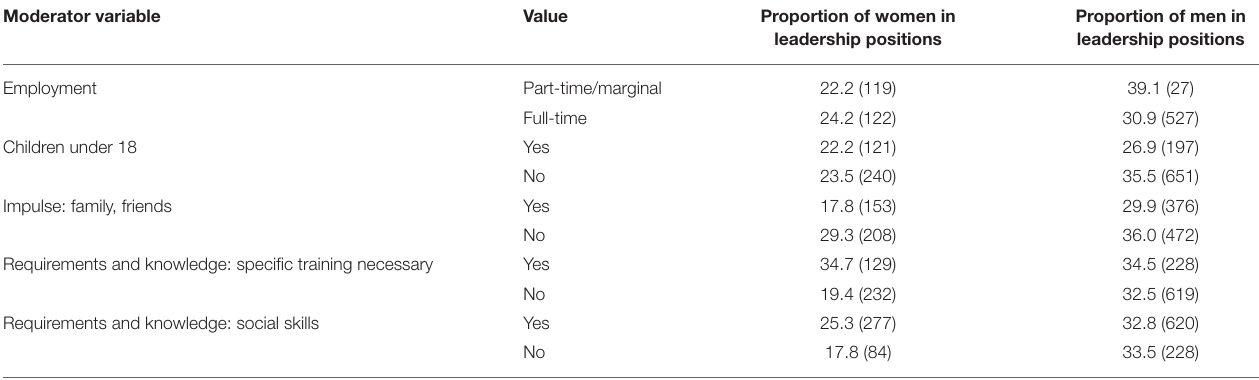
TABLE 9 | Proportion of volunteers in leadership positions by gender and different moderator